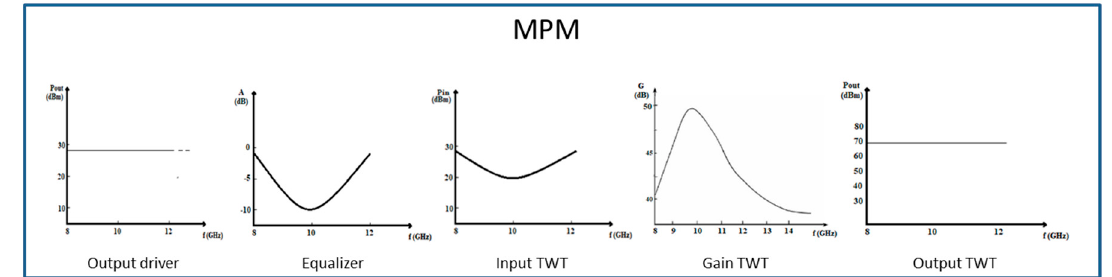
Figure 2. Typical input and output curves for a microwave power module with an equalizer used for a helix TWT.